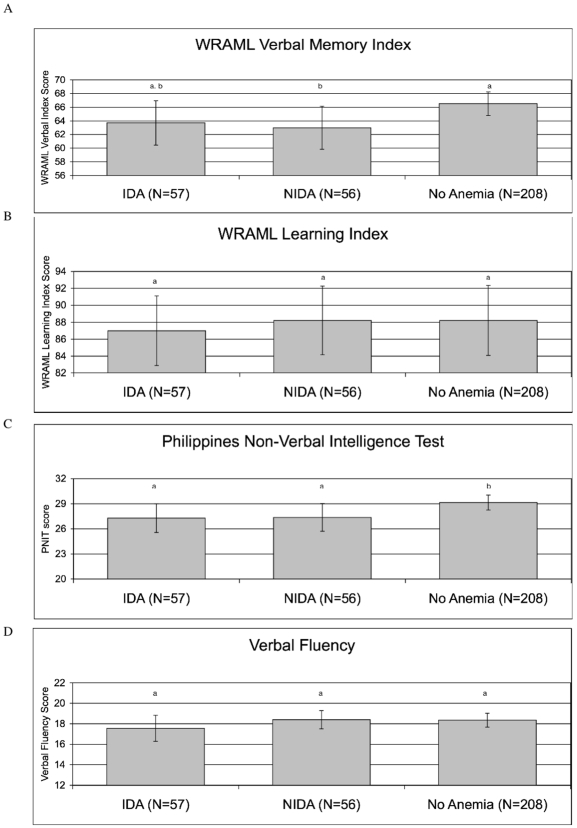
Least Squares Mean Scores on Tests of Cognition by anemia category after adjustment for age, sex, socio-economic status, and body mass index z-score.Error bars represent 95% confidence intervals. a, b Different letters represent significant differences (P<0.05) in scores across anemia categories. IDA = Iron Deficiency Anemia; NIDA = Non-Iron Deficiency Anemia; WRAML = Wide Range Assessment of Memory and Learning.